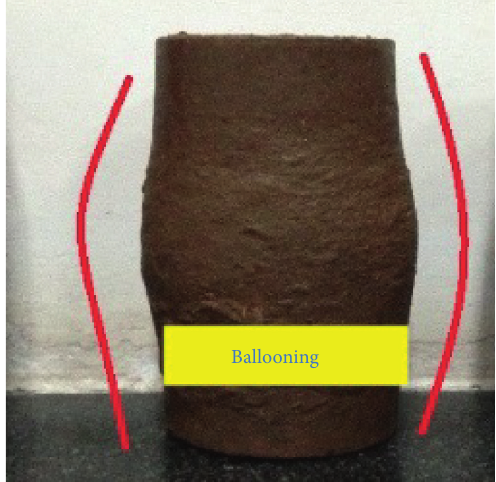
Figure 22: Appearances of natural soils after failure.